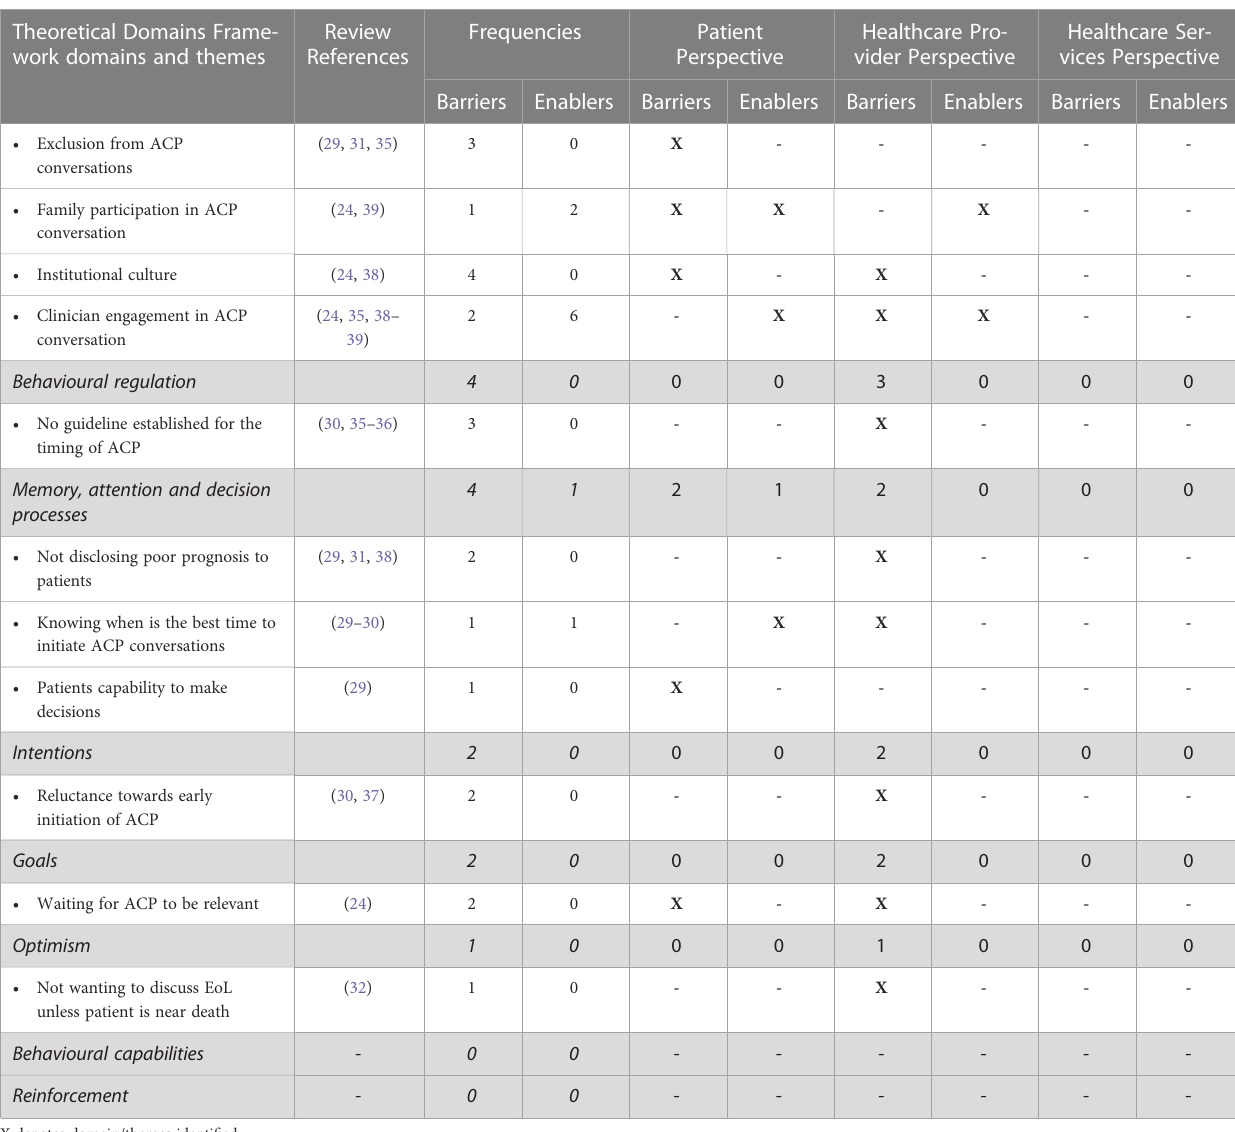
Table 5 compares the frequencies of Theoretical Domains Framework domains for barriers of ACP with the Theoretical Domains Framework domains for implied barriers targeted by ACP interventions across patient, healthcare provider, and healthcare systems levels. Across levels, there was a misalignment between barriers identi fi ed and implied barriers targeted by interventions. Interventions most frequently targeted the patient; however, more barriers for ACP were identi fi ed for healthcare providers. There were also implied barriers targeted by ACP interventions that were not identi fi ed as barriers to ACP in the included reviews. This occurred for interventions targeting the patient as well as the healthcare